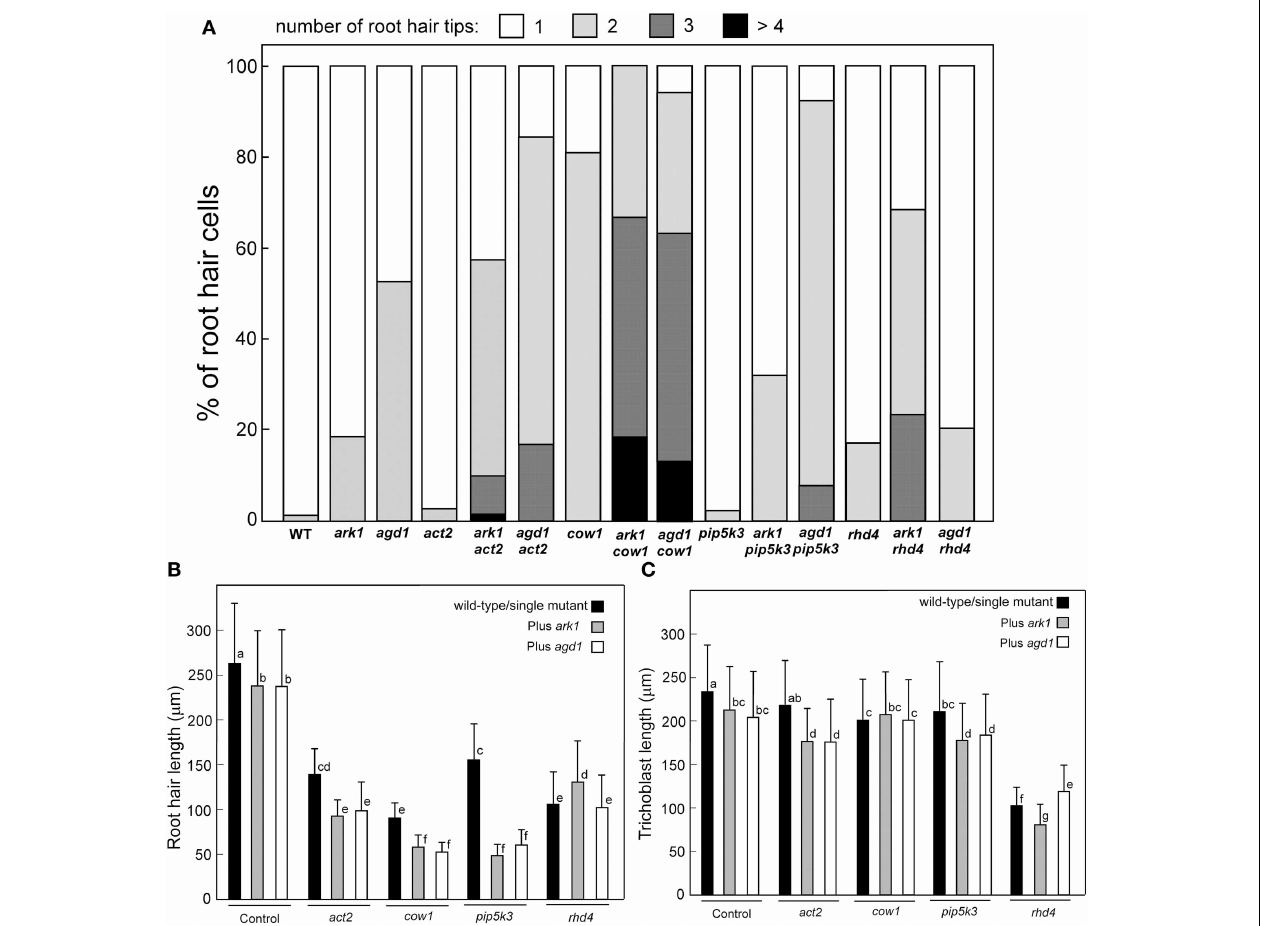
FIGURE 3 | Quantification of root hair defects in agd1 and ark1 single and various mutant combinations. (A) Frequency of multiple tips. Root hair tips from each root hair or initiation site were counted, and numbers of the root hair tips are presented as a percentage of the number of root hairs sampled. More than 100 trichoblasts were sampled for each single mutant/double mutant. Quantification of root hair (B) and trichoblast (C) length. Black bar indicates the average